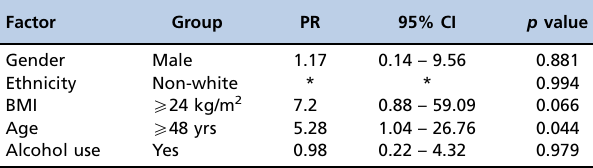
Table 2 - Prevalence Rates of Qualitative and Categorized Quantitative Variables – Violent Death. Factor Group PR